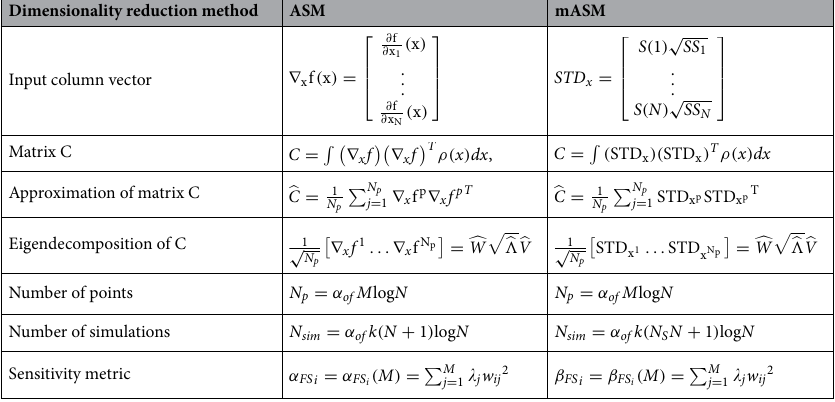
Table 2. Comparison of ASM and mASM. ASM Active subspaces method, mASM modified